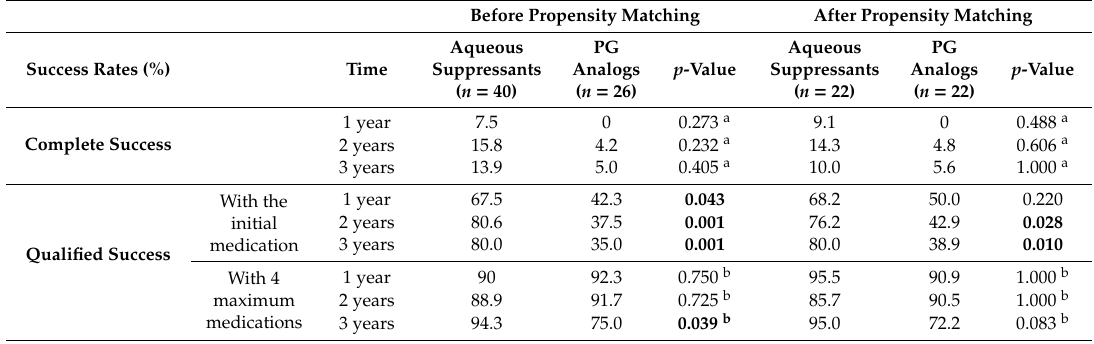
Table 3. Success rates assessed with two di ff erent criteria of the number of postoperative medications. Before Propensity Matching After Propensity Matching Success Rates (%)